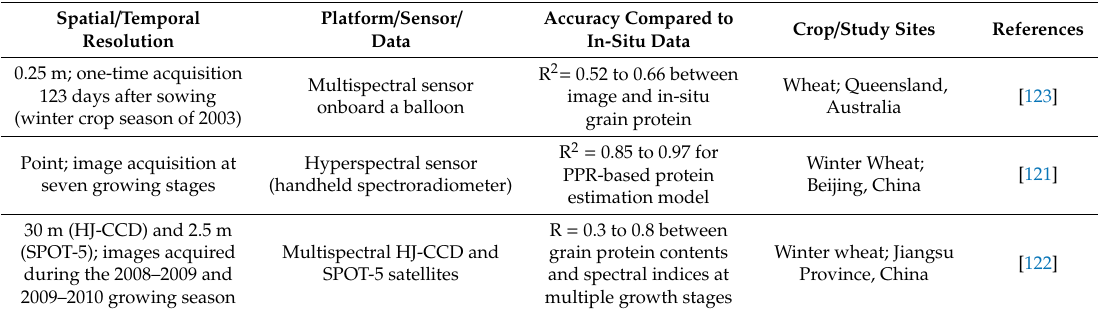
Table 10. Studies conducted for crop protein assessment using RS